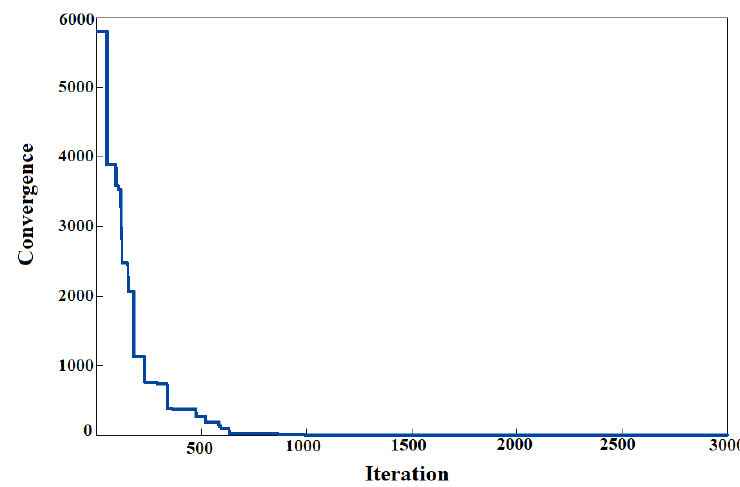
Figure 11. Convergence graph of the objective function.